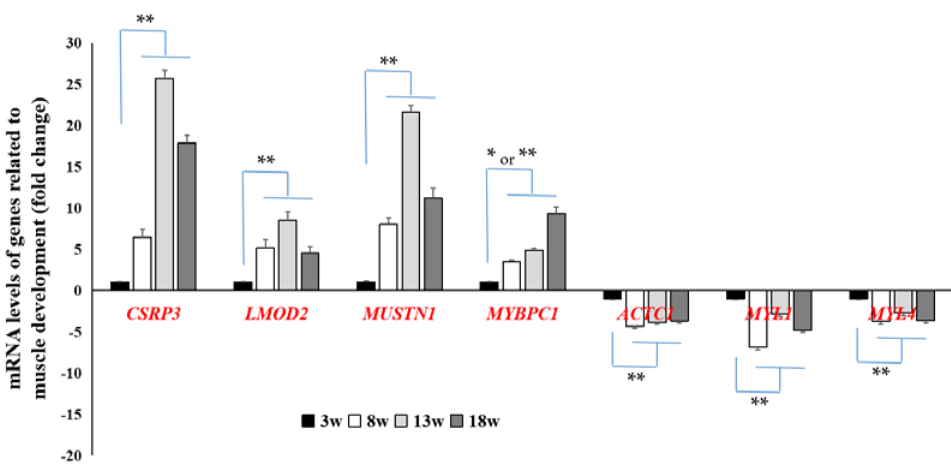
Figure 4. Verification of DEGs related to muscle development by quantitative real-time polymerase chain reaction (qRT-PCR). These DEGs were significantly upregulated or downregulated (* p < 0.05 or ** p < 0.01) in breast muscle tissue at 8, 13, and 18 weeks when compared to those at 3 weeks. n = 9.